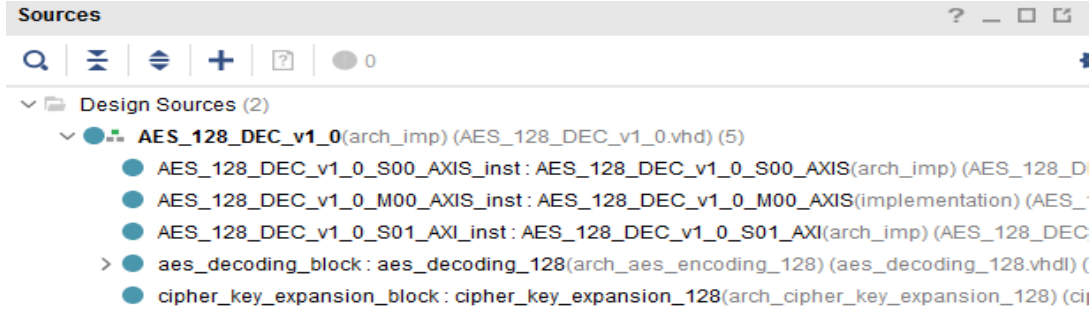
Figure 18. Source files used to implement the code performing the decryption process.